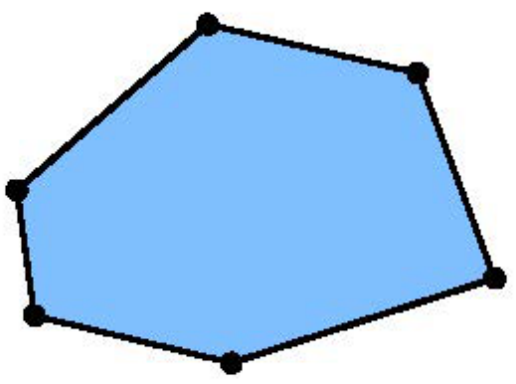
Figure 33: A two-dimensional